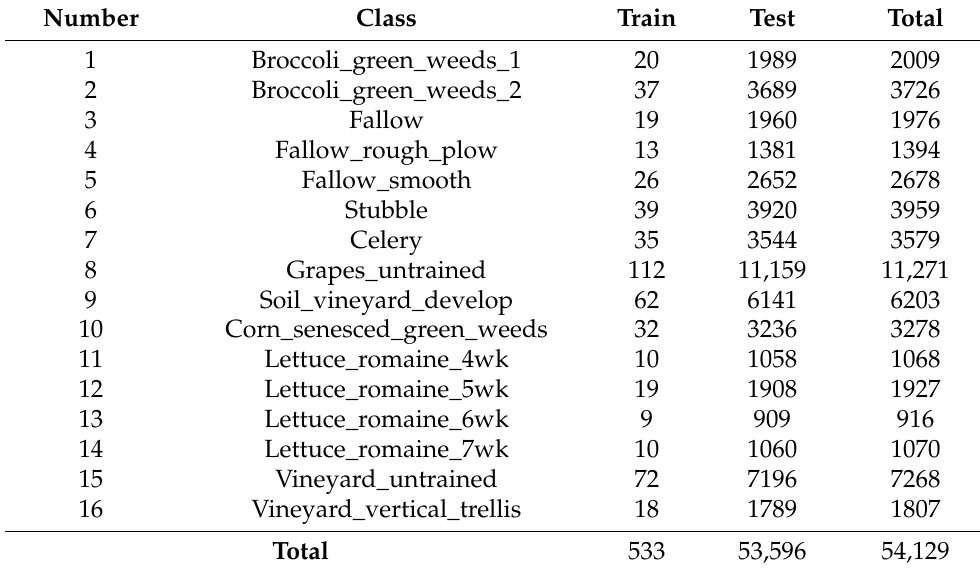
Table 8. The samples for each category of training and testing for the Salinas